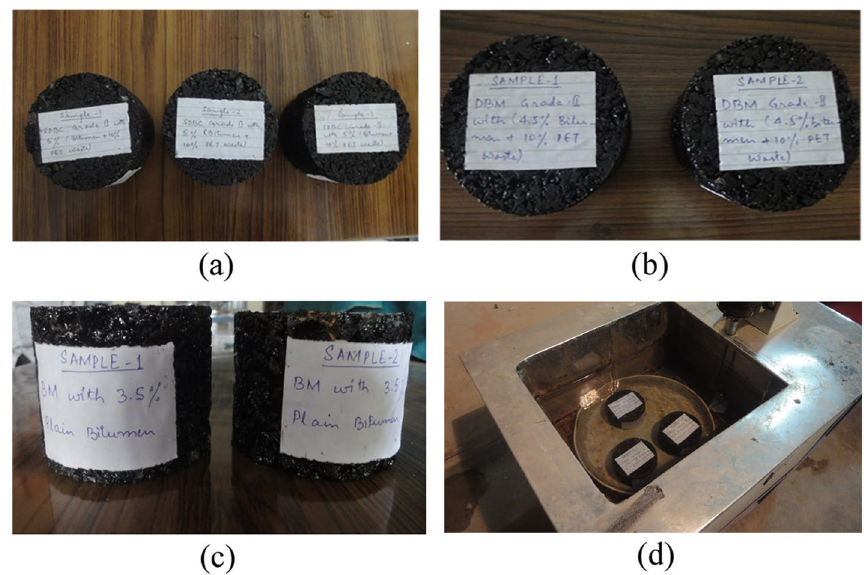
Fig. 5 Different Marshall samples. a Marshall samples for SDBC. b Marshall samples for DBM. c Marshall samples for Bituminous Macadam. d Marshall samples in thermostatically controlled water bath